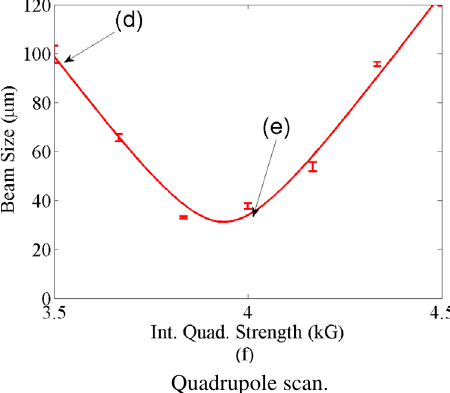
FIG. 29. Quadrupole scans and examples of bunch profiles for 100 pC bunches. The resulting normalized emittances are 1.09 mm-mrad and 0.81 mm-mrad, respectively, from the fits to the horizontal data in plot (c), and the vertical emittance is 0.66 mm-mrad from the fit to the data in plot